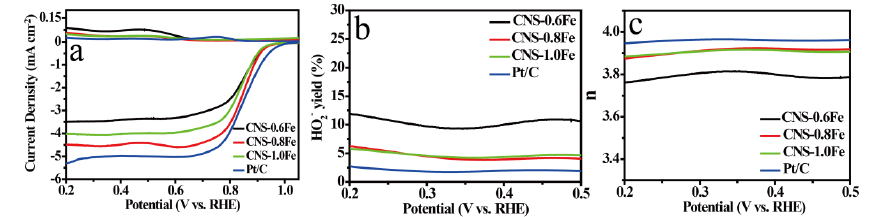
Figure 8. ( a ) Rotating ring disk electrode (RRDE) tests of CNS – 0.6Fe, CNS – 0.8Fe, CNS – 1.0Fe and Pt/C at 1600 rpm. ( b ) The HO 2 − yields, ( c ) electron transfer number.